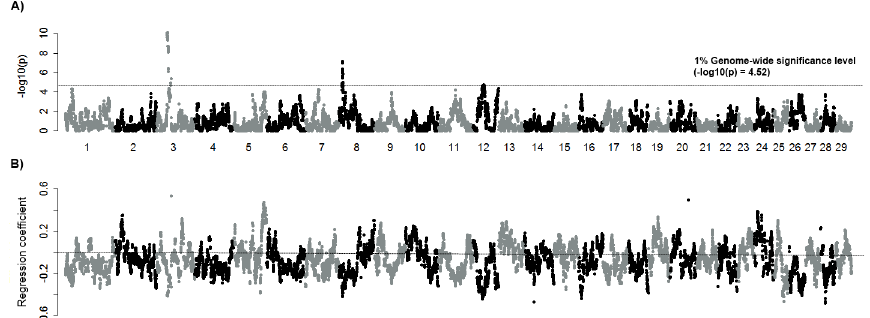
Fig 3. ROH-DPR associations. A) Significance of ROH-DPR association B) Effect of ROH-DPR association. A dotted line shows genome-wide significant threshold (adjusted 1% level, A). The positive or negative effect of daughter pregnancy rate (DPR) and ROH, which are defined by the slope of regression is plotted across the genome (B). Negative effect represents the region with decreased the levels of DPR by increased levels of ROH.